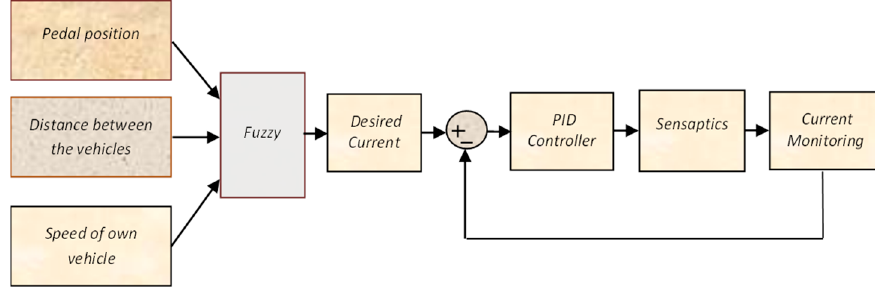
Figure 7. Schematic of the controller for the SDAS.